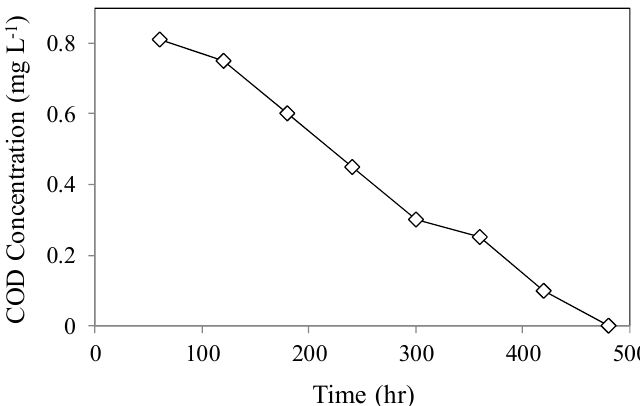
Figure 10. The chemical oxygen demand (COD) analysis of TP2 under photodegradation of MB dye.